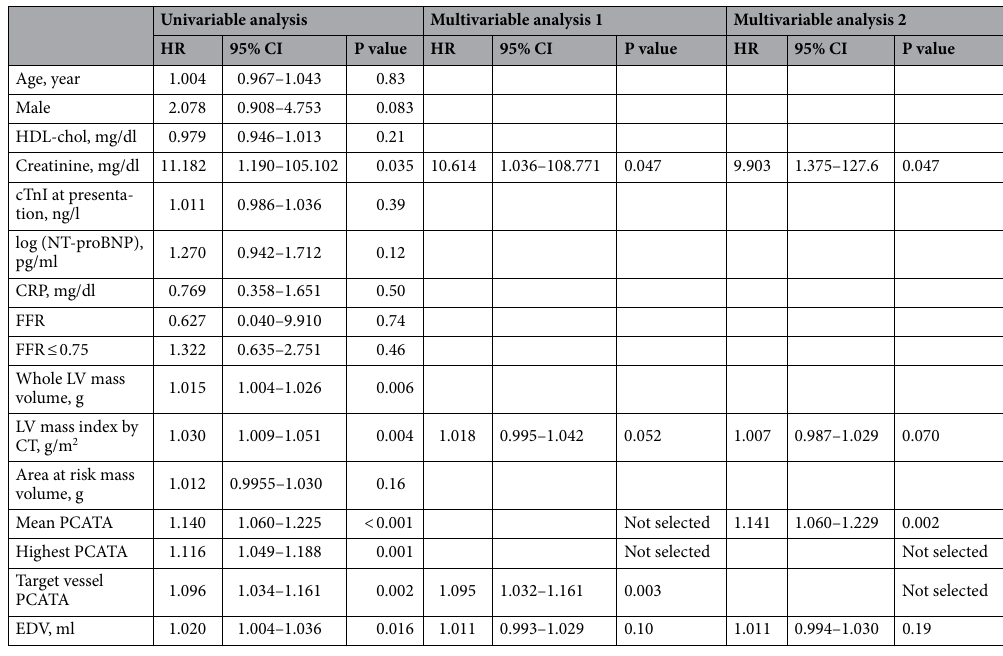
Table 4. Univariate and multivariate logistic regression analysis for factors to predict impaired g-CFR (g-CFR < 2.0).